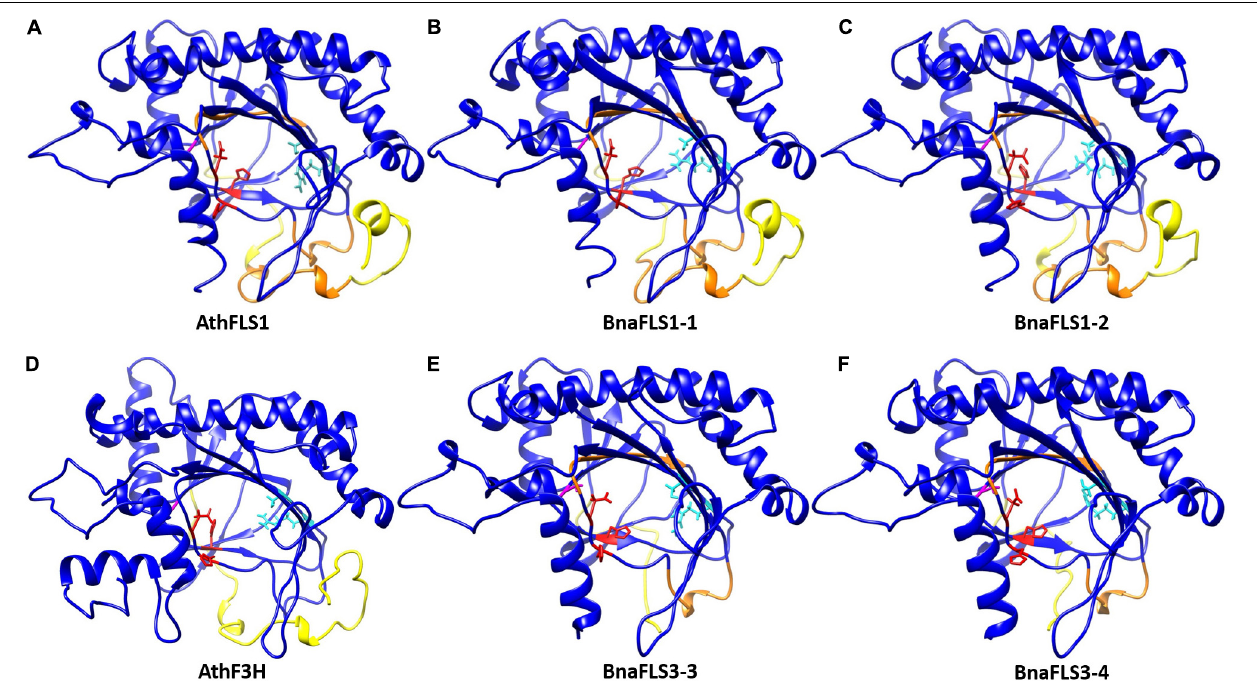
FIGURE 7 | 3D secondary structure models of BnaFLS1s and BnaFLS3s. Homology models of (A) AthFLS1, (B) BnaFLS1-1, (C) BnaFLS1-2, (D) AthF3H, (E) BnaFLS3-3, and (F) BnaFLS3-4 modeled via I-TASSER are shown looking into the center of the jellyroll motif. Ferrous iron-coordinating residues are shown in red, 2 - oxoglutarate binding residues are marked in cyan, and the corresponding position of G261 in AthFLS1 is shown in magenta. The N-terminus divergence between BnaFLS1s and BnaFLS3s is marked in yellow (corresponding to amino acids 1-42 in AthFLS1). Orange regions compromise regions postulated to be specific for